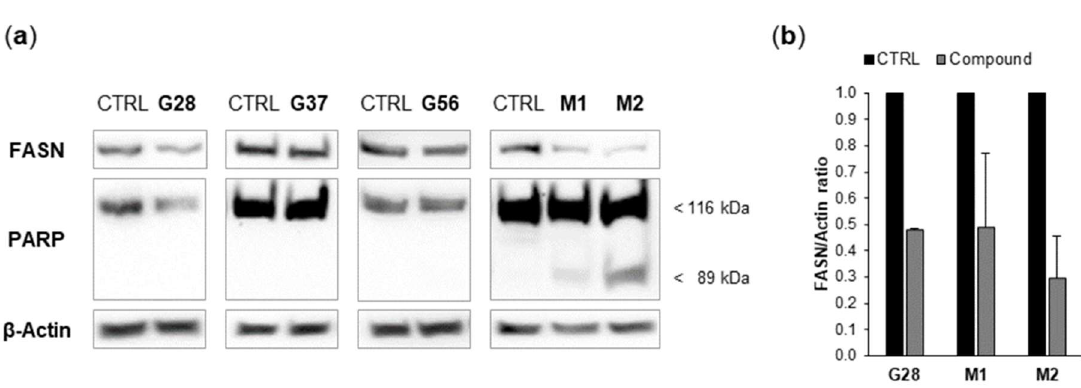
Figure 3. ( a ) G28, G37, G56 [21,22], M1 and M2 [26] differentially affect FASN protein expression in MDA-MB-231 TNBC cells, and only M1 and M2 induce apoptosis, as determined by poly(ADP-ribose) polymerase (PARP) cleavage. Cells were treated for 24 h with a 5-fold IC 50 concentration of G28, G56, M1 and M2, a 2-fold IC 50 concentration of G37, or with DMSO. Equal amounts of lysates were immunoblotted with anti-FASN and anti-PARP antibodies (the latter identified intact and cleaved PARP at 116 and 89 kDa, respectively). Blots were reproved for β -actin as loading control. Gels shown are equivalent to those obtained from two or three independent experiments. ( b ) G28, M1 and M2 downregulate FASN protein expression. FASN and β -actin immunoblot bands were quantified by densitometry and FASN/ β -actin ratios of treatments are represented relative to those of controls. Data are mean ± SE from two or three independent experiments.